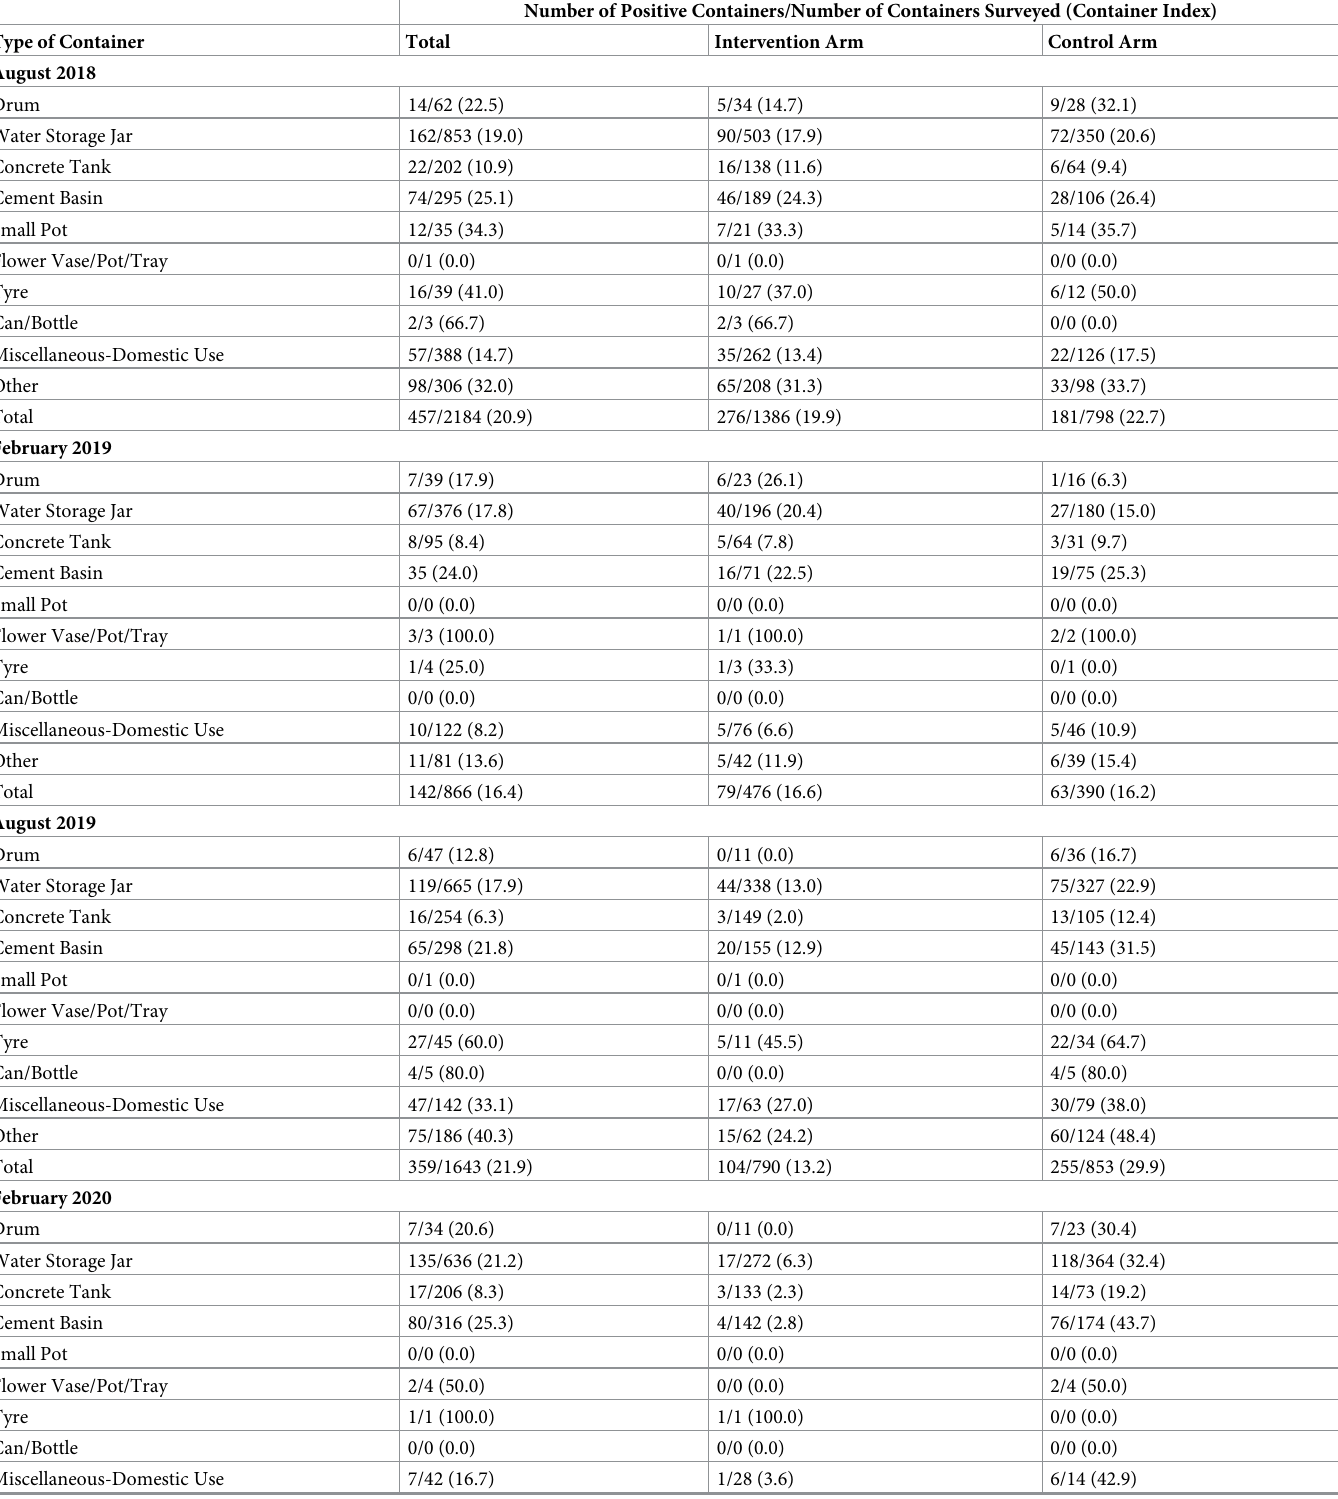
Table 4. Container Index by container type, study arm and survey time